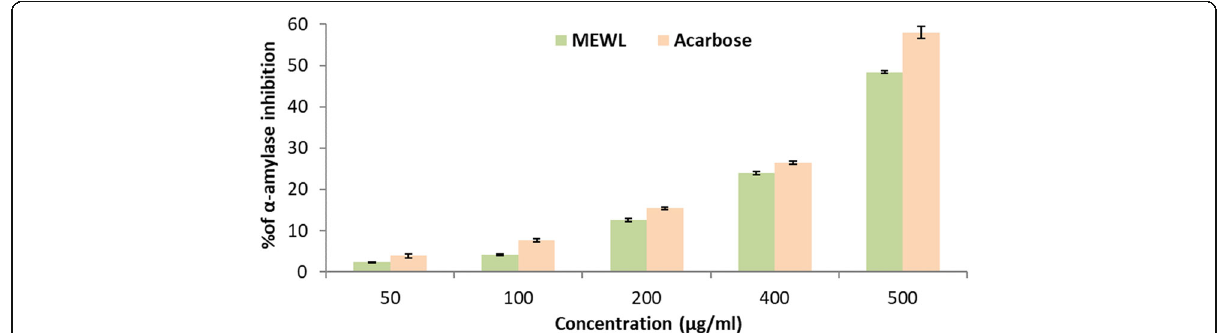
Fig. 1 α -amylase inhibition activity of methanolic extract of W. chinensis leaf (MEWL). All data are expressed as mean ± SD (n; number of separate experiments =